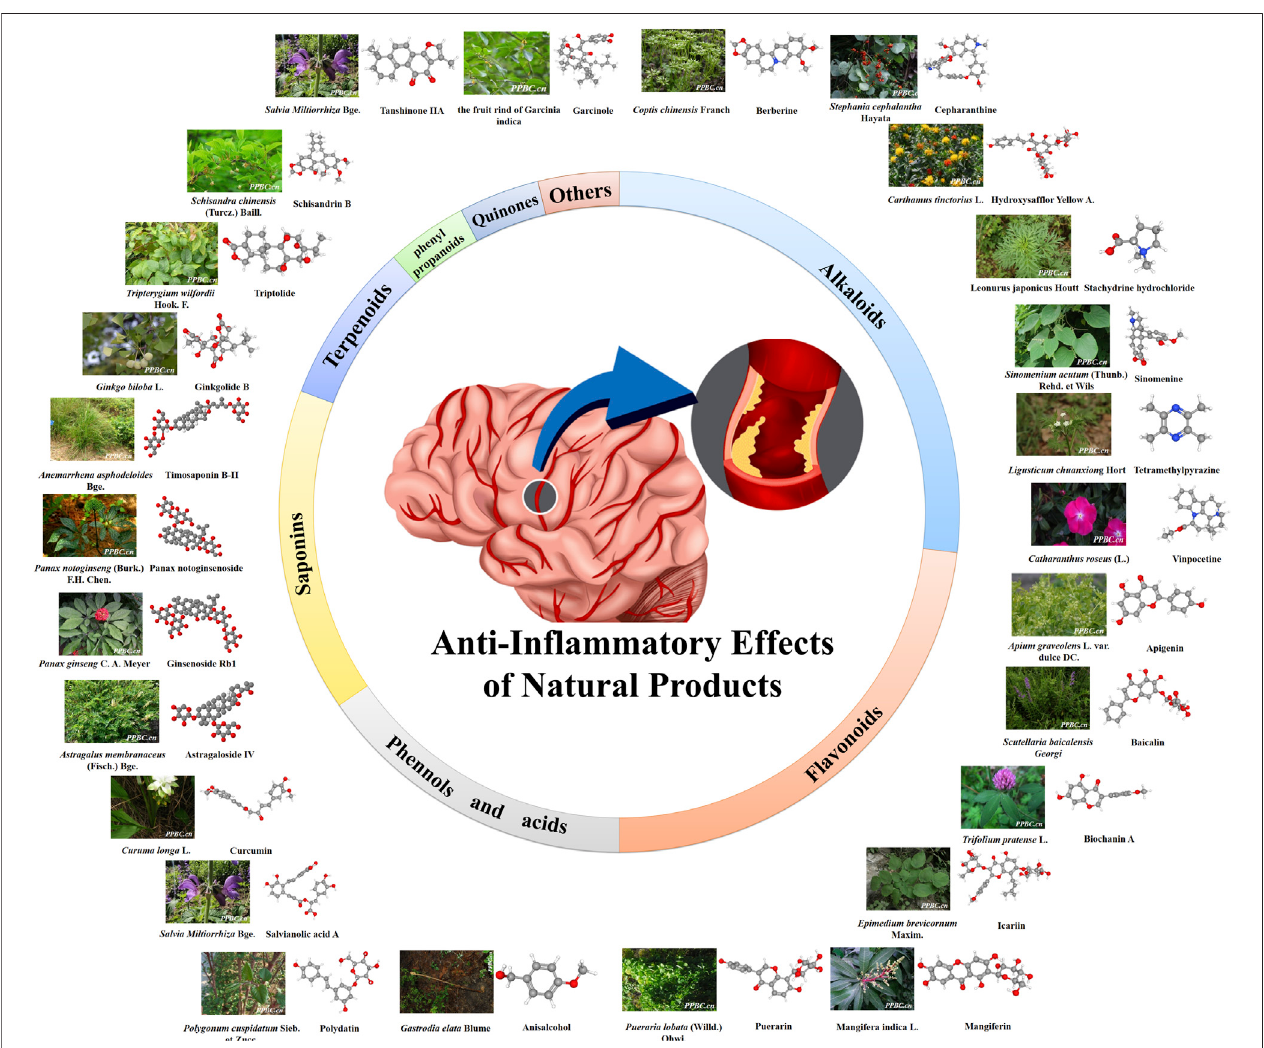
FIGURE 2 | Anti-in fl ammatory effect of natural products. The color fi gures of medicine are viewed in www.iplant.cn. The club model comes from PubChem and Guidechem.